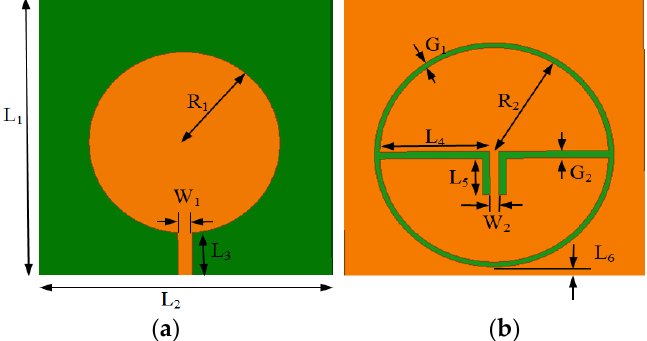
Figure 6. Structure of the proposed antenna. ( a ) Top view. ( b ) Bottom view.